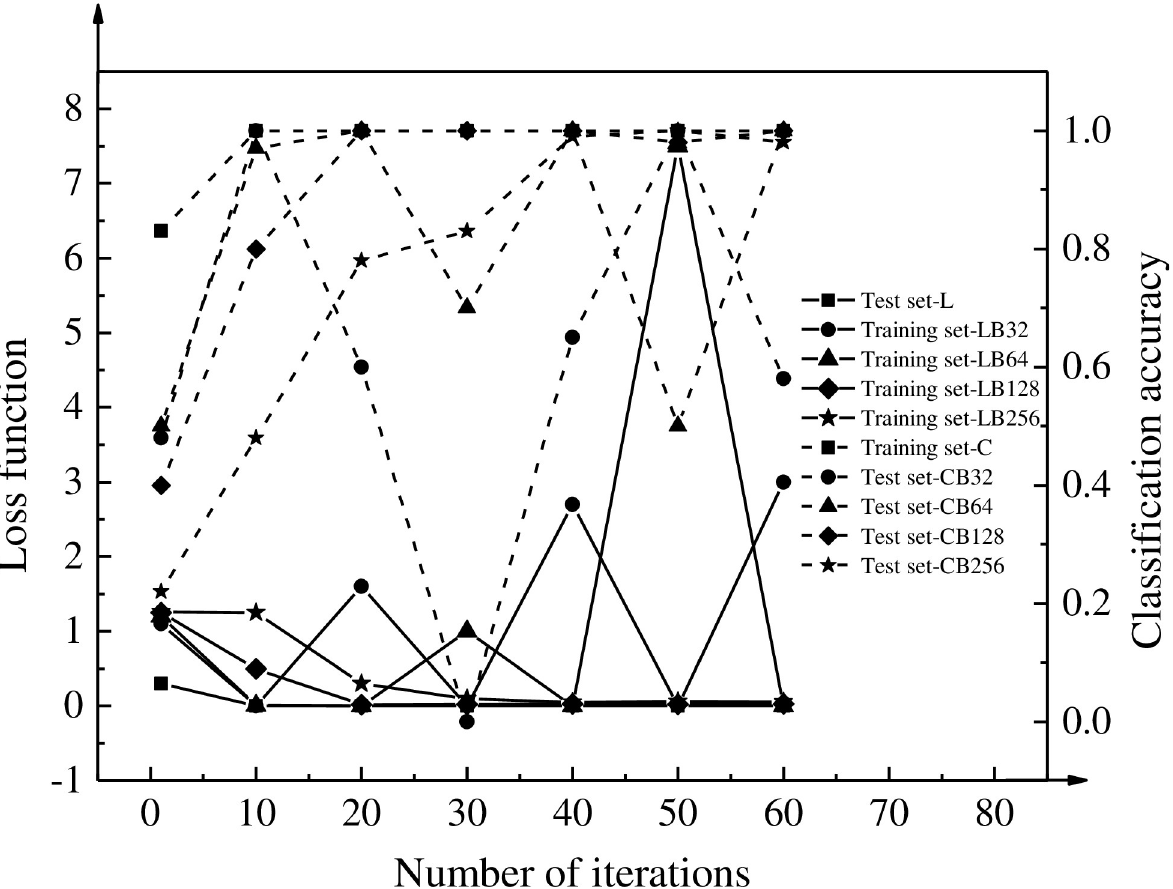
Fig 11. Changes in classification accuracy and loss function when the convolution kernel size is 7 � 1. Note: in the legend, L and C refers to the loss function and classification accuracy,